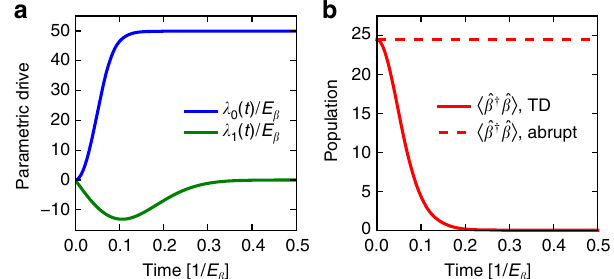
Figure 2 | Initialization of the mechanical state. Fast turn on of mechanical parametric driving using the TD scheme (see main text). ( a ) Time dependence of the parametric driving strength l ( t ) ¼ l 0 ( t ) þ i l 1 ( t ), r ( t ) [tanh 2 r ( t ) ¼ l 0 ( t )/ D ]. The final value of l ( t ) corresponds to e 2 r ¼